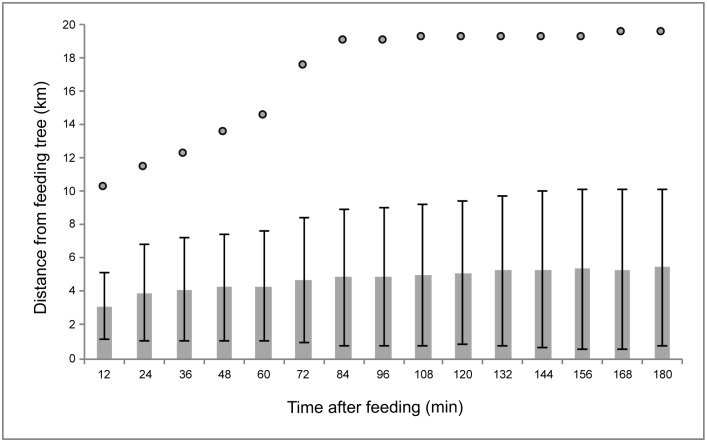
Travel distances of Madagascan flying foxes.Distances travelled by 11 Pteropus rufus bats from fig trees for up to 3 h after feeding (the time in which most droppings containing more than 25 seeds were produced in our GRT study–see Fig 3). The position of the bat was considered every 12 min as a straight line along its flight path in relation to the feeding tree it used. The bars represent average recorded distance from the feeding sites (n = 71) with the standard deviation. The circles indicate the maximum distance recorded.